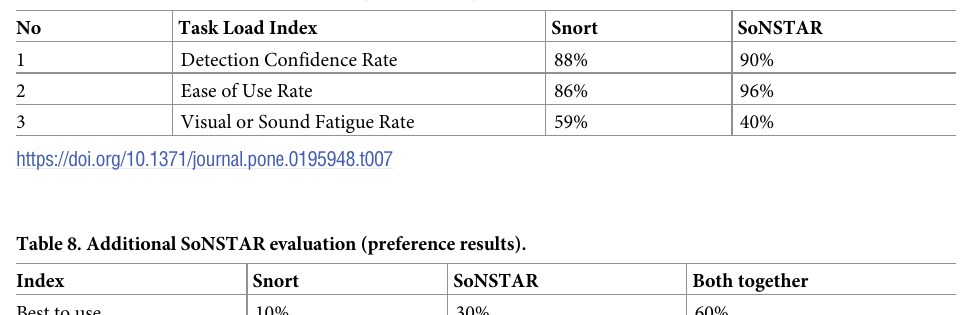
Table 7. Additional SoNSTAR evaluation (index results).